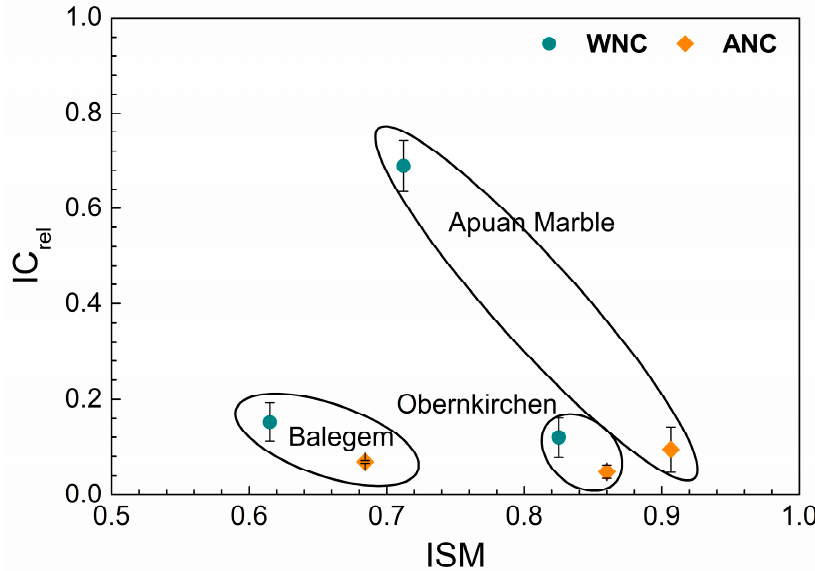
Figure 5. Correlation between the index of surface modification (ISM, Equation (3)) and IC rel (see Section 2.4.2) for lithotypes after treatment with WNC/ANC.